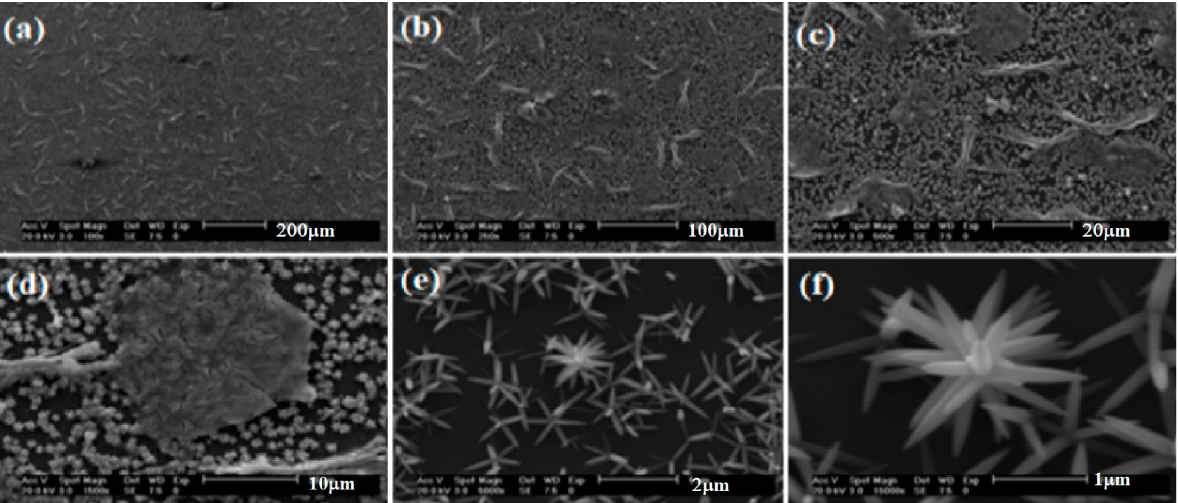
Figure 5. Typical FESEM images of the bunches (nanoflowers) of synthesized ZnO nanosheets at 85 ◦ C for ZnO with pH 10 at different scales: ( a ) 200 µ m, ( b ) 100 µ m, ( c ) 20 µ m, ( d ) 10 µ m, ( e ) 2 µ m, ( f ) 1 µ m.